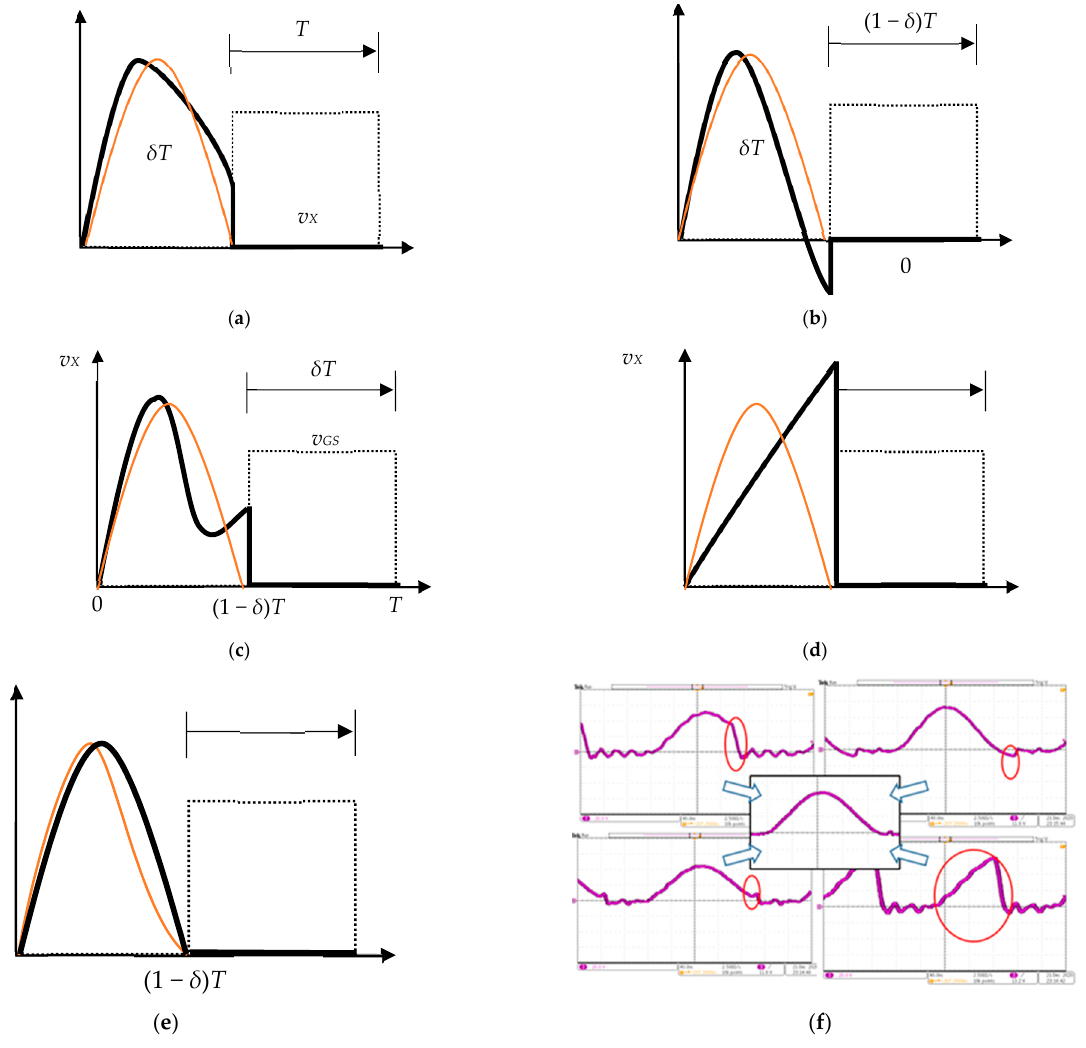
Figure 7. ( a ) ω o should be fixed and δ should be decreased; ( b ) ω o should be fixed and δ should be increased; ( c ) both ω o and δ should be increased; ( d ) ω o should be increased and δ should be fixed; ( e ) slightly decrease ω o and fix δ for ZCS; ( f ) the experiment correspondences.